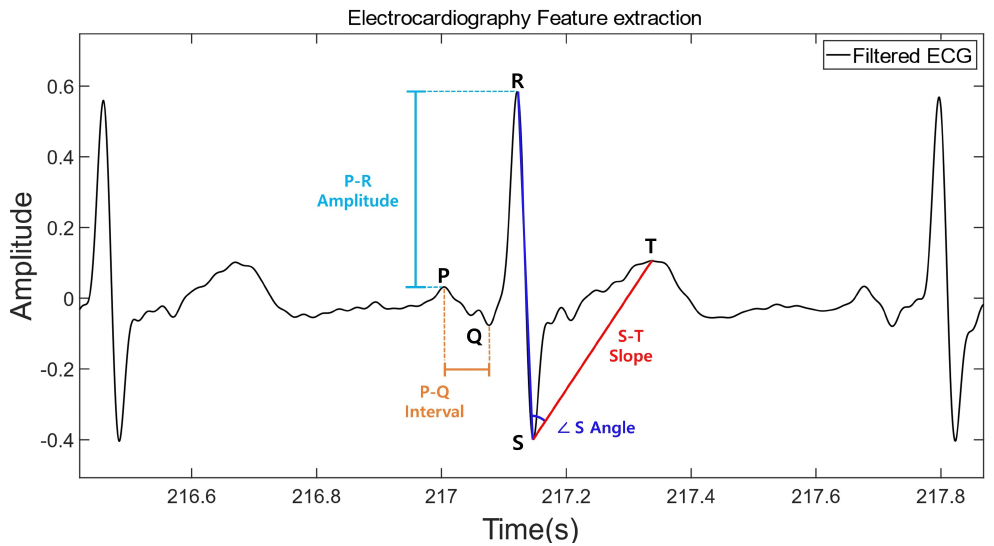
Figure 1. ECG feature extraction. Features were extracted from the amplitudes, intervals, angles, and slopes of the P, Q, R, S, and T peaks and the combinations of their peak